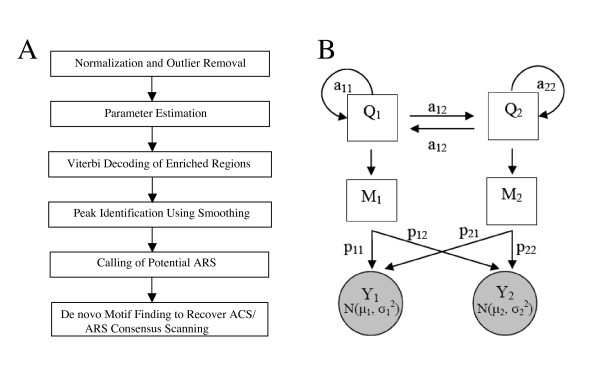
Analysis of ORC and Mcm2p whole genome localization experiments using a tiled oligonucleotide array. A. Strategy. B. The Hidden Markov Model with Mixture of Gaussian output. Round shapes represent continuous variables and square shapes represent discrete variables. Gray refers to observed variables.